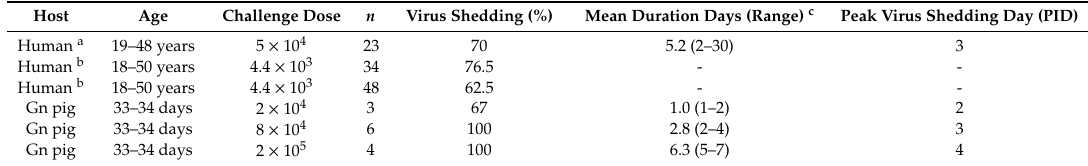
Table 3. Comparison of virus shedding in unvaccinated Gn pigs and humans after inoculation with GII.4 / 2003 HuNoV